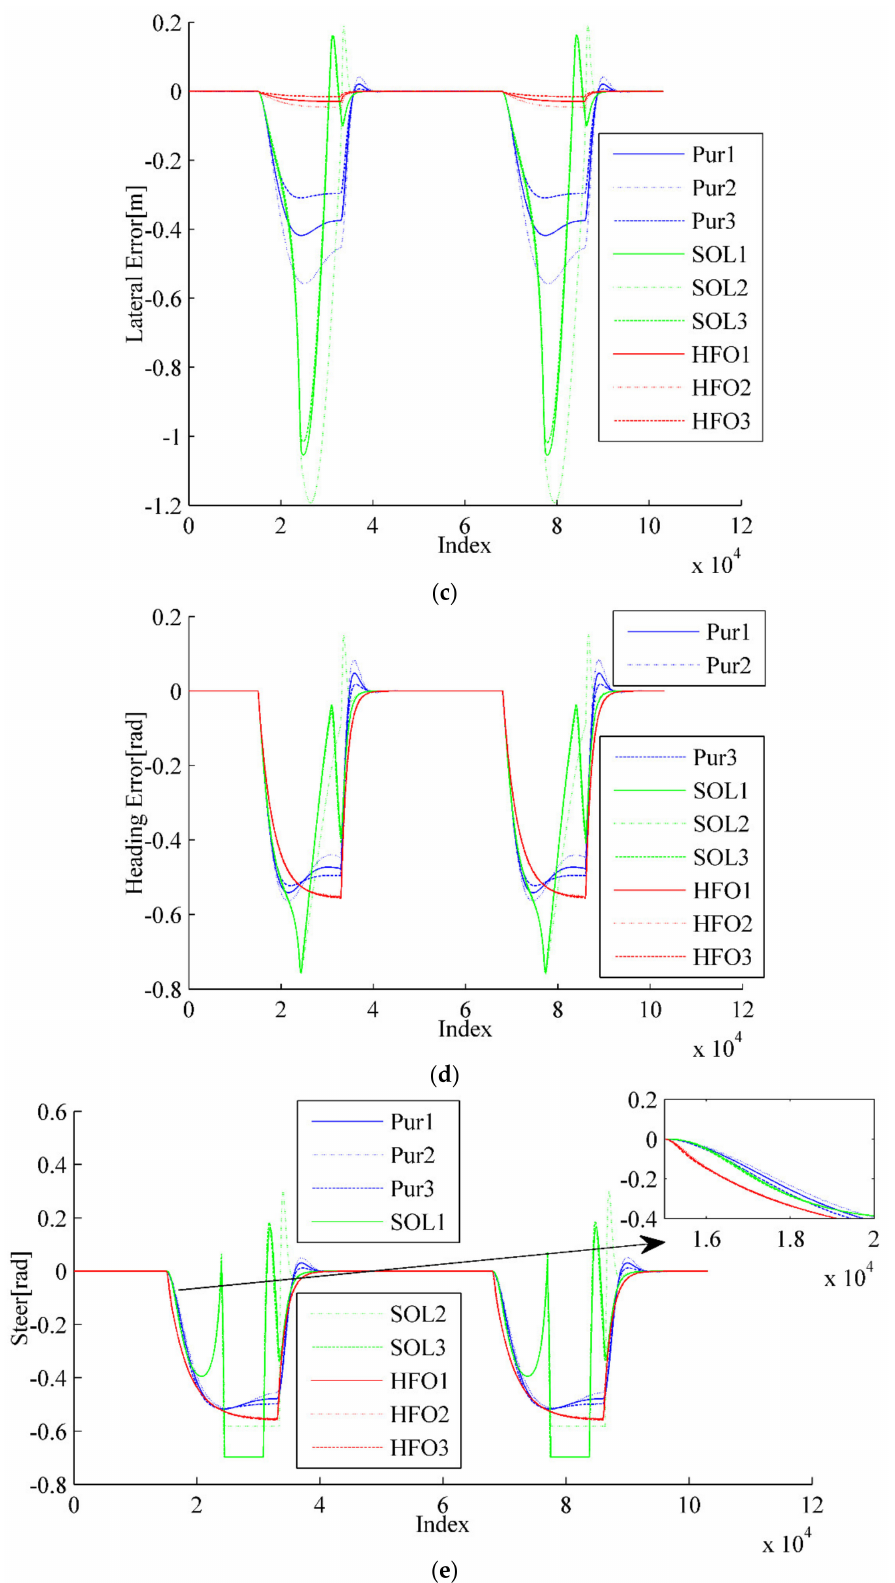
Figure 6. Ring test scenario. ( a ) Trajectory tracking (3D), ( b ) Trajectory tracking (2D), ( c ) Lateral error, ( d ) Heading angle, ( e ) Steer